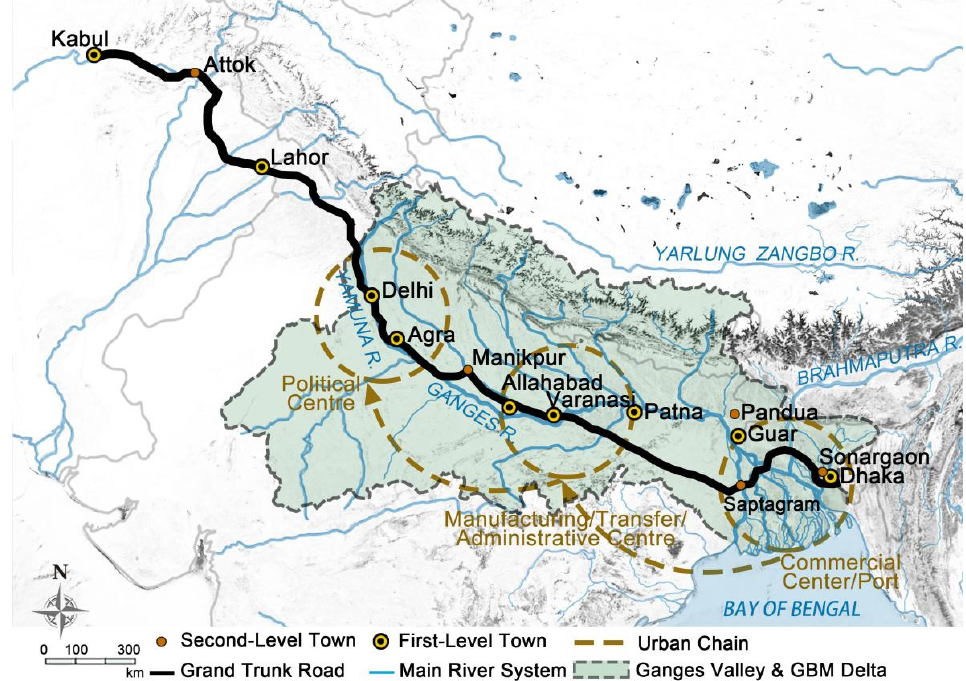
Figure 5. The “Grand Trunk Road”, with the chain of towns of Mughal’s “Poliscratic” strategy in the Ganges Valley. Source: the authors; Base Map: Google satellite map; Reference: https://vikramjits.wordpress.com/?s=grand+trunk+road (accessed on 1 November 2022).